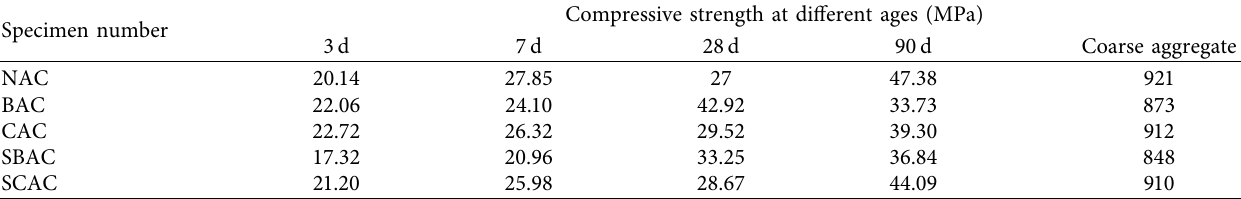
Table 3: Three-day, 7d, 28 d, and 90d compressive strength of concrete NAC, BAC, CAC, SBAC, and SCAC.